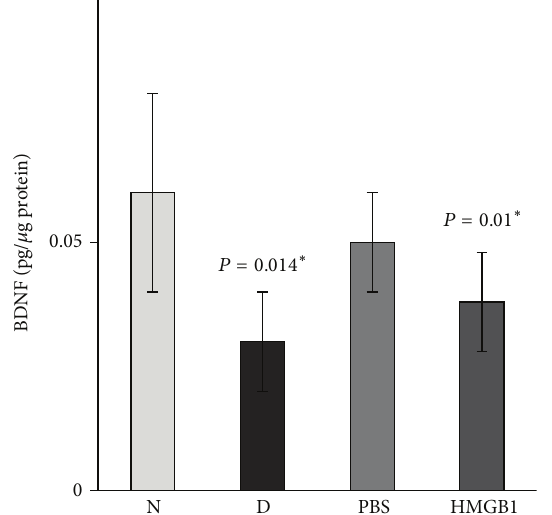
Figure 2: Enzyme-linked immunosorbent assay for brain-derived neurotrophic factor (BDNF) in rat retinas. There is a significant decrease in the expression of BDNF in the retinas of diabetic rats (D) compared with the nondiabetic control rats (N). Intravitreal administration of high-mobility group box-1 (HMGB1) induced a significant downregulation of the expression of BDNF compared with intravitreal administration of phosphate buffer saline (PBS). Each experiment was repeated 2 to 3 times with fresh samples ( 𝑛 = 6 ).